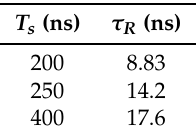
Table 6. Measured rise times τ R obtained with T s of 200, 250 and 400 ns.